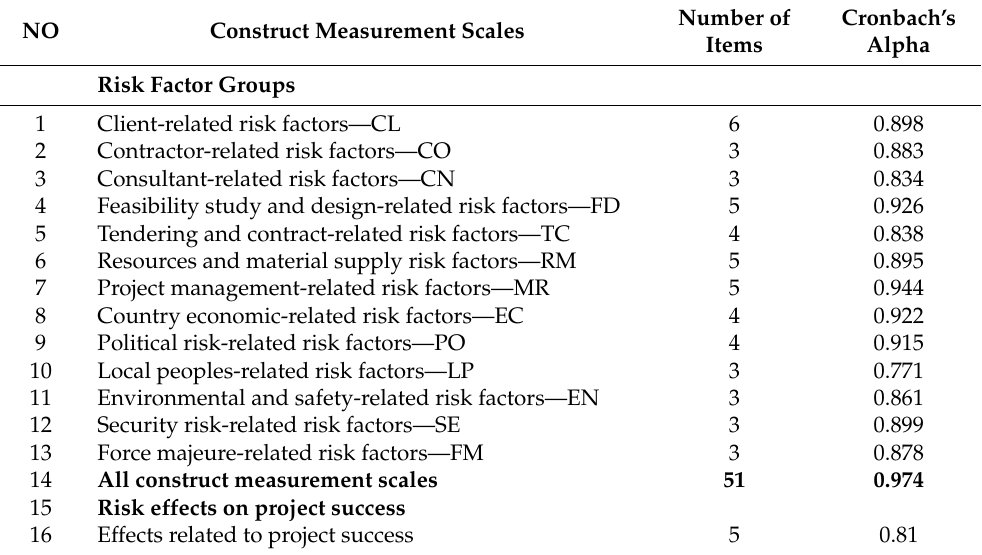
Table 5. Cronbach’s alpha test of risk factors and effects (pilot study)